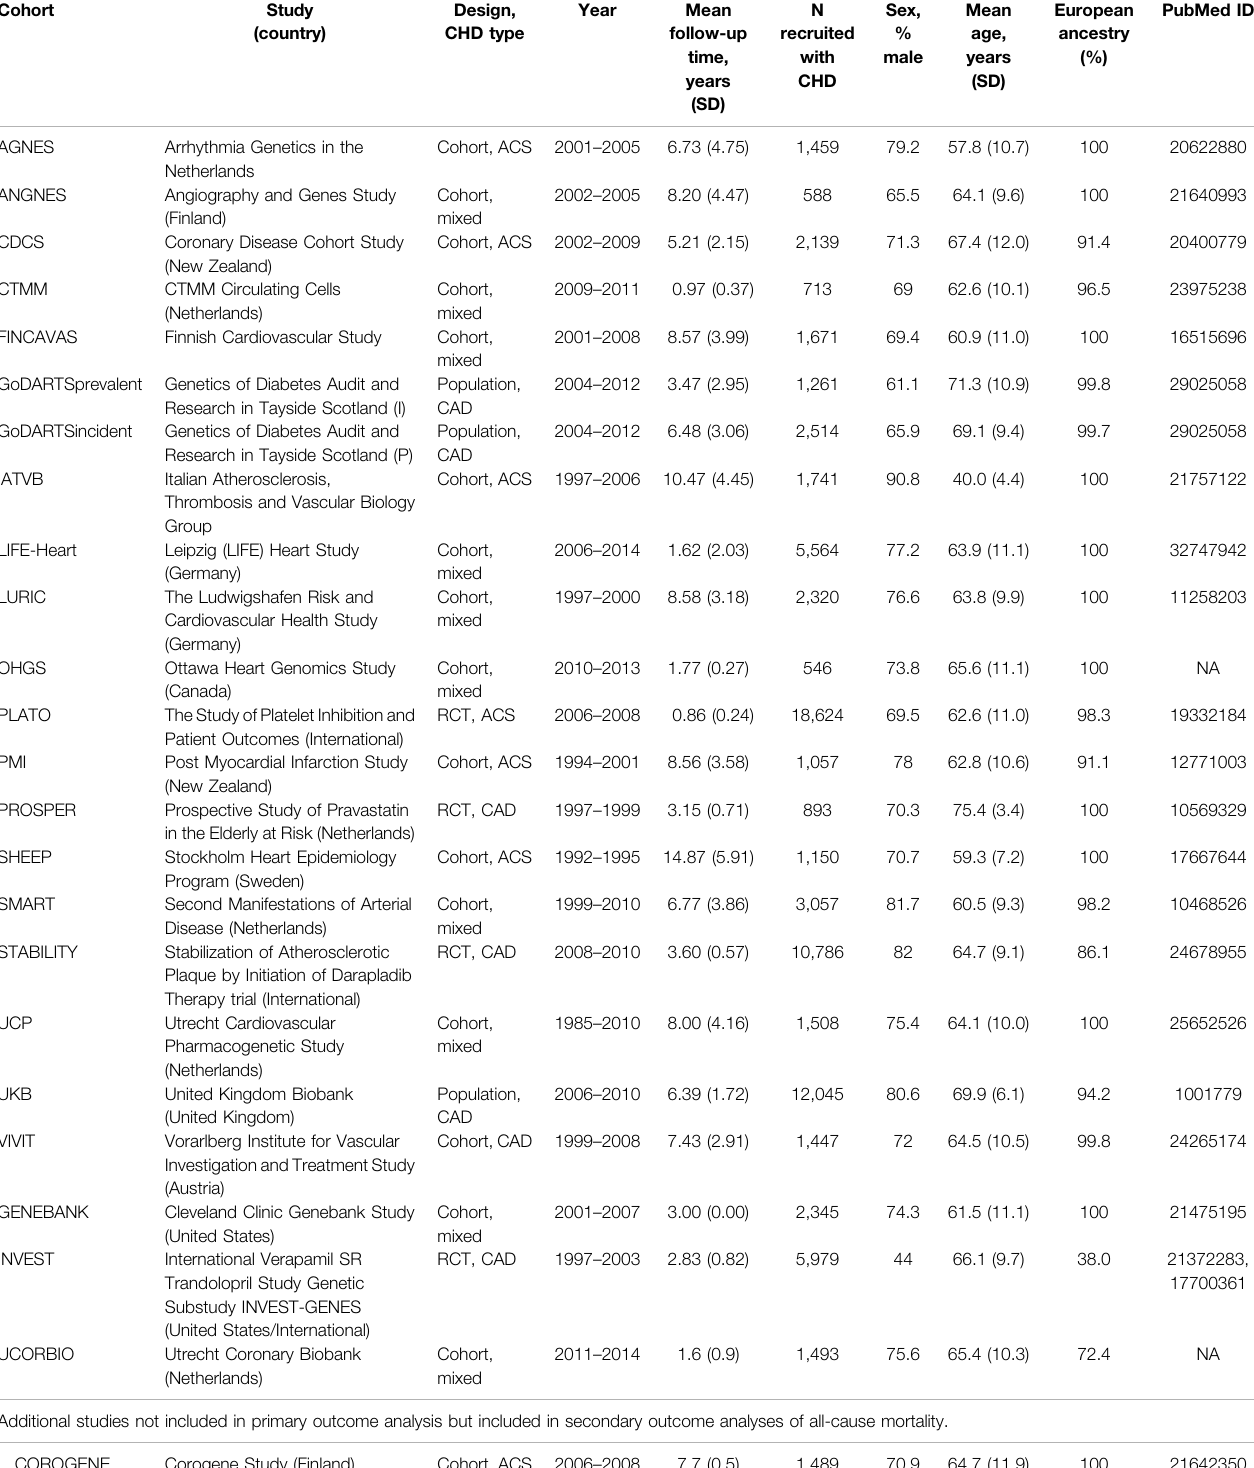
TABLE 1 | Characteristics of studies included in the